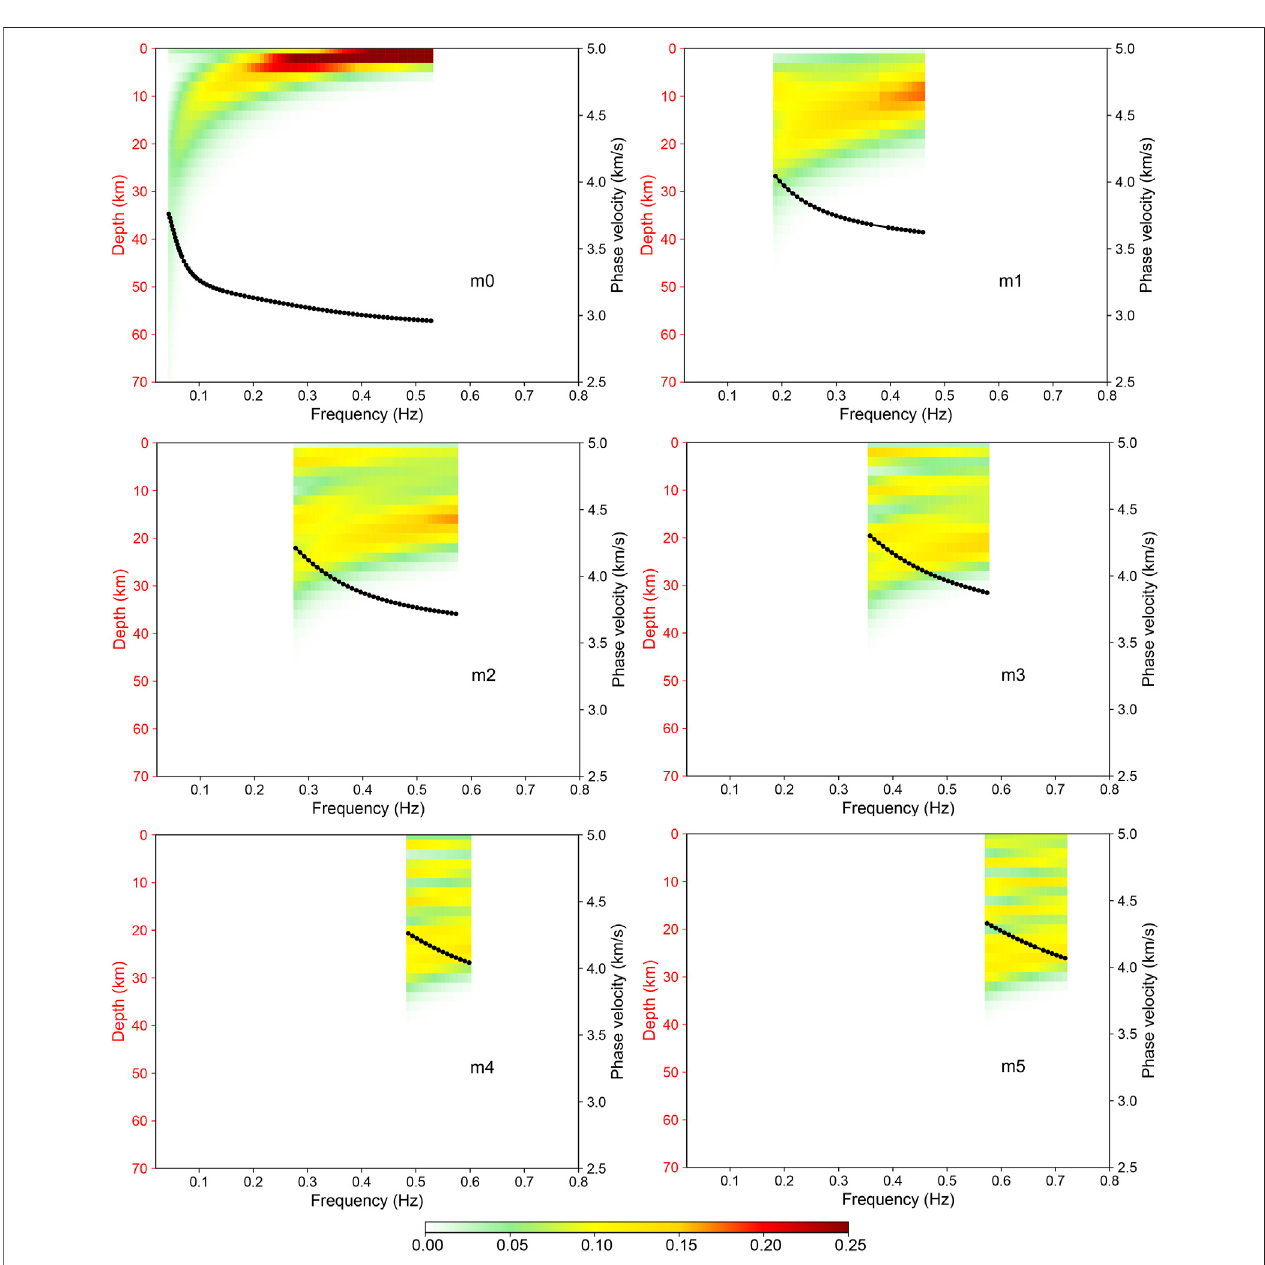
FIGURE 7 | Depth and frequency distributions of the sensitivity kernel function of the fi nal model of the multimodal dispersion curve inversion for array “ ZV ” .